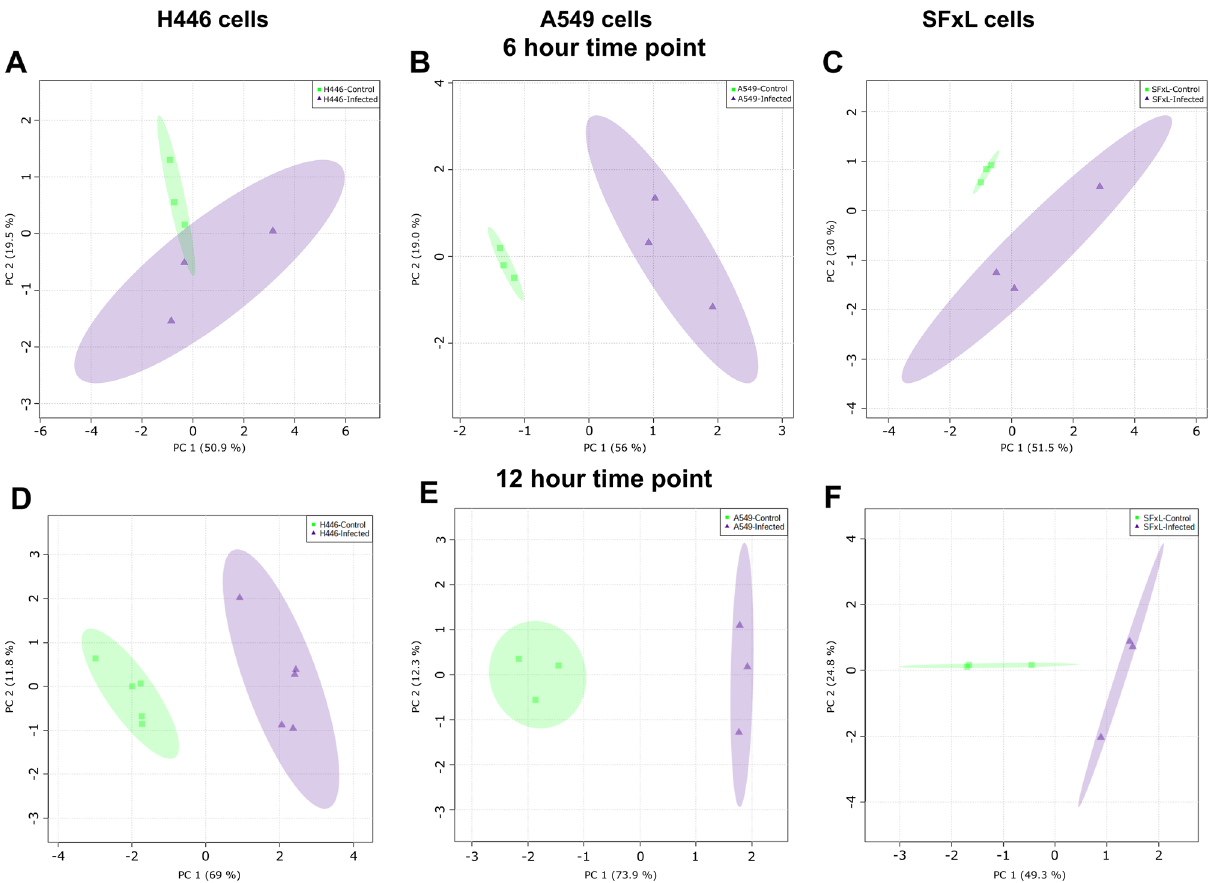
Figure 2. Unsupervised multivariate analysis of control and infected cells: 2D scores plots of the principal component analysis (PCA) from GC-MS data for H446, A549, and SFxL cancer cells at 6 h post infection panels ( A ), ( B ), and ( C ), respectively and 12 h post infection panels ( D ), ( E ), and ( F ), respectively. The amount of variance explained for PC 1 and 2 are displayed in parentheses. The shaded areas indicate the confidence regions (95%) based on the data points for each condition in the PCA models. The unsupervised PCA models suggest a powerful effect due to myxoma